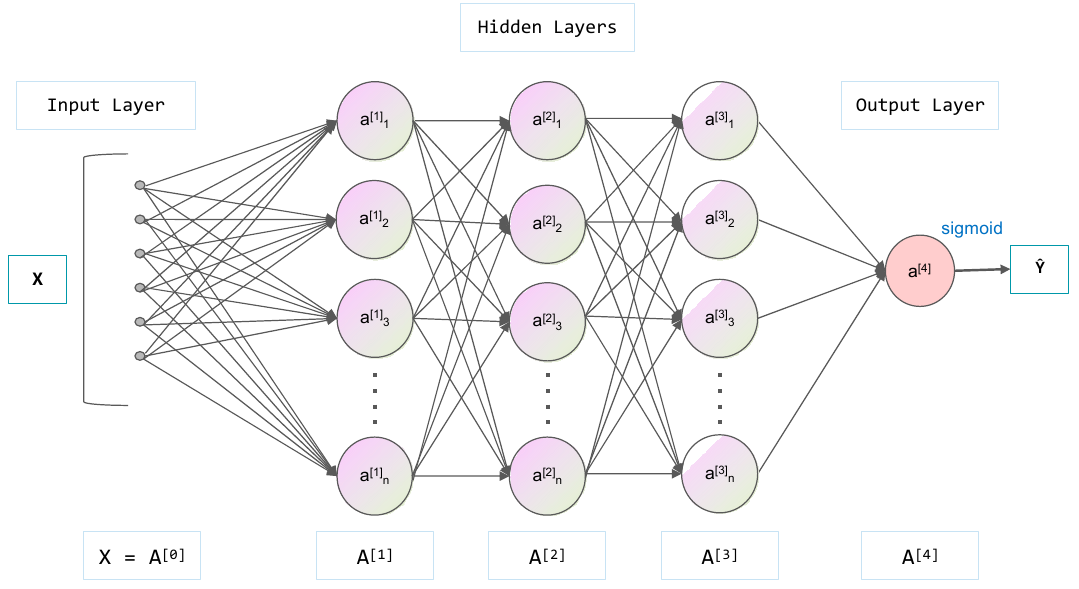
Figure 4. Diagram of the neural network structure. Figure 5a denotes the variation of the average entropy loss vs. the training epochs.